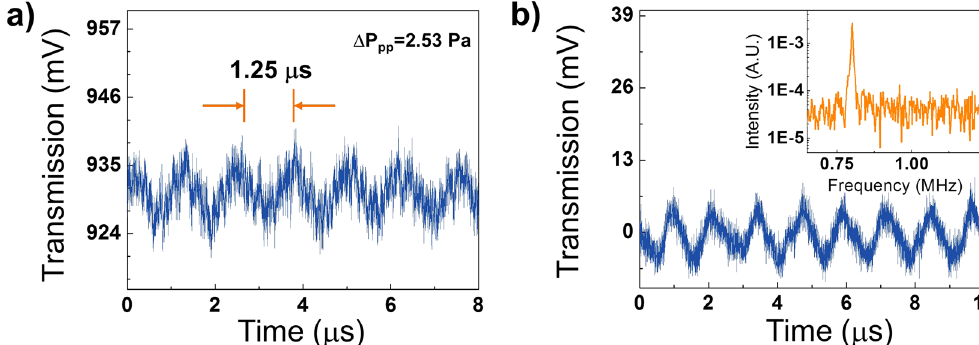
Figure 2. ( a ) Temporal trace detected by a DC-coupled photodetector connected to an oscilloscope. The peak- to-peak pressure at the resonator was 2.53 Pa (see Fig. S2b for the pressure calibration curve). 1.25 μ s period corresponds to the 800 kHz pressure wave from the air-coupled ultrasound transducer. ( b ) Temporal trace detected by an AC-coupled photodetector. The temporal response of the ring resonator ( a = 90 μ m) for 10.3 Pa (peak-to-peak) incident pressure wave. Inset: Spectral response of the ring resonator obtained using fast Fourier